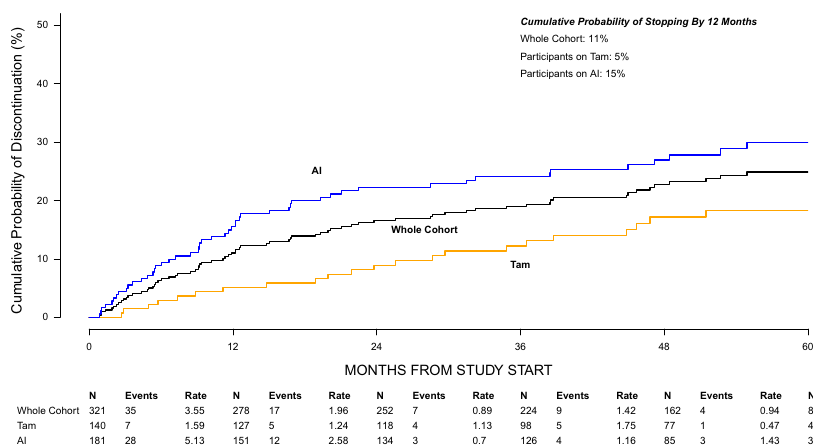
Fig. 4 Cumulative probability of endocrine therapy discontinuation. Curves depict time to discontinuation of endocrine therapy for the entire cohort and according to type of endocrine therapy. AI aromatase inhibitor, Tam tamoxifen.